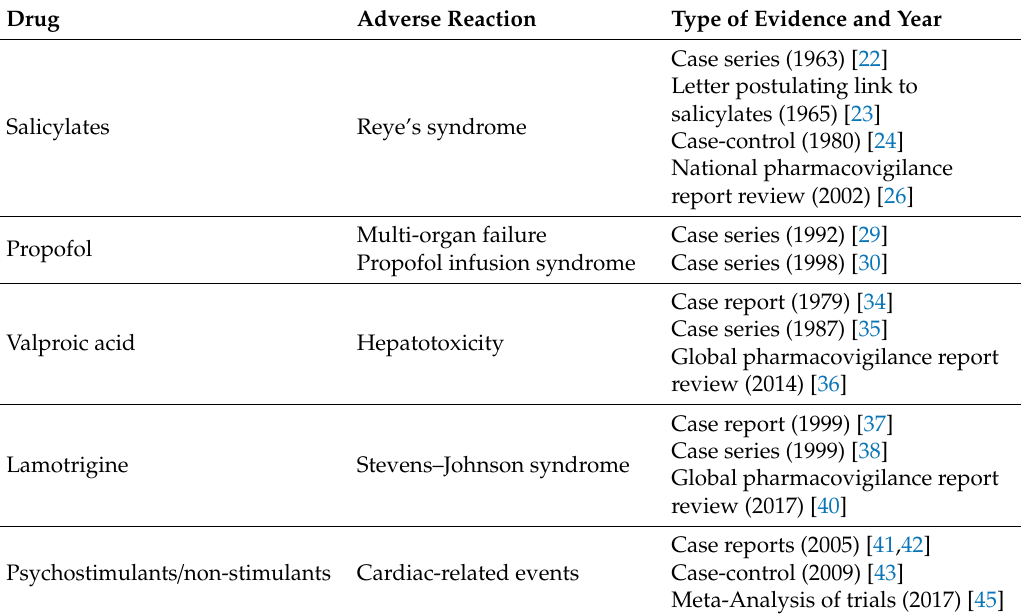
Table 2. Drug toxicity in